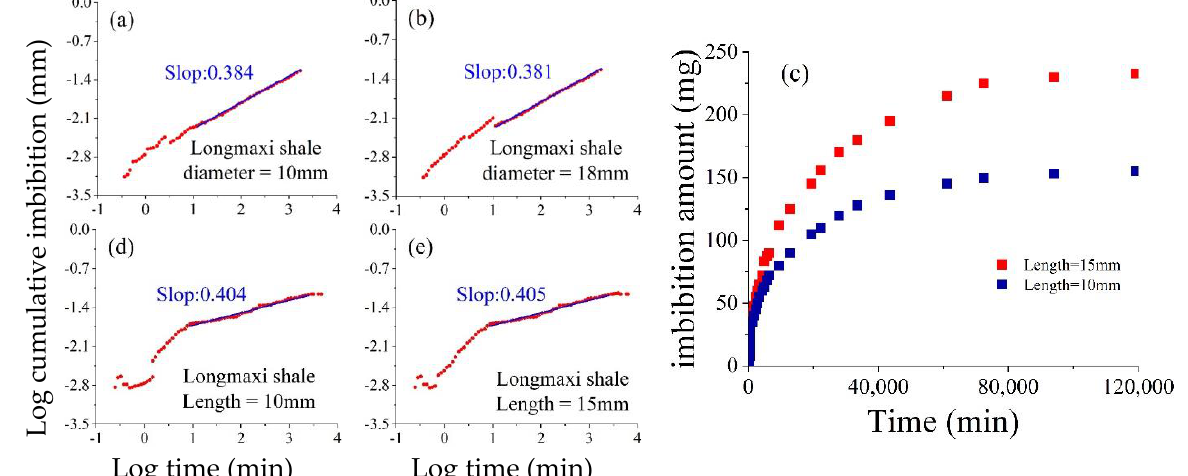
Figure 8. Log cumulative water i mbibition versus log imbibition time for the different diameter and length shale samples. Samples of ( a ) 10 mm and ( b ) 18 mm in diameter for cumulative imbibition. Samples of ( c ) 10 mm and 15 mm in length for imbibition amount. Samples of ( d ) 10 mm and ( e ) 15 mm in length for cumulative imbibition.